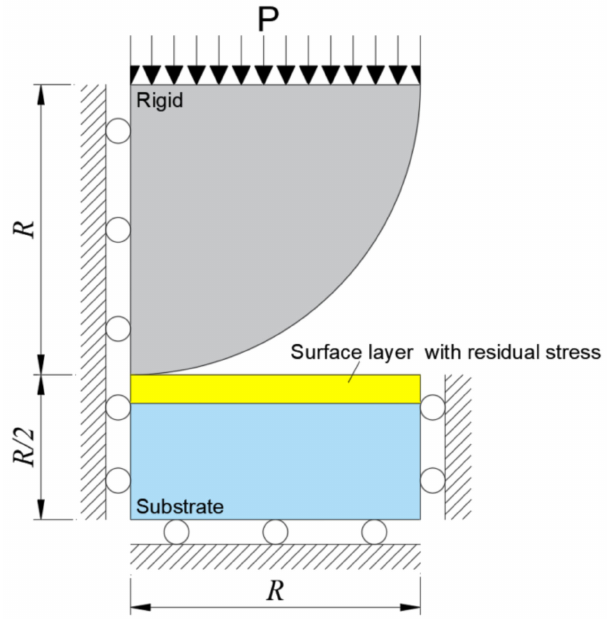
Figure 2. Finite element model.